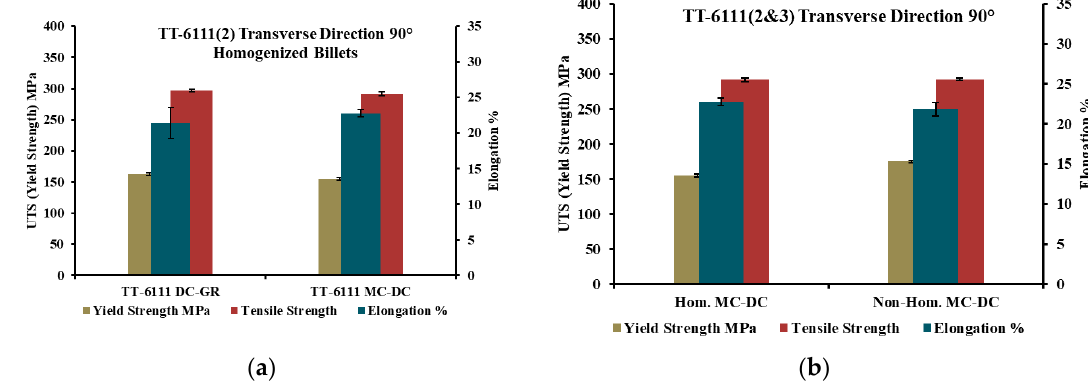
Figure 9. The mechanical properties of as-cast planks extruded from TT-6111 (2 and 3) billets in the transverse direction; ( a ) TT-6111 (2) planks extruded from homogenized DC-GR and MC-DC billets; ( b ) Comparison of the mechanical properties of TT-6111 (2) and TT-6111 (3) planks extruded from MC-DC casting billets.